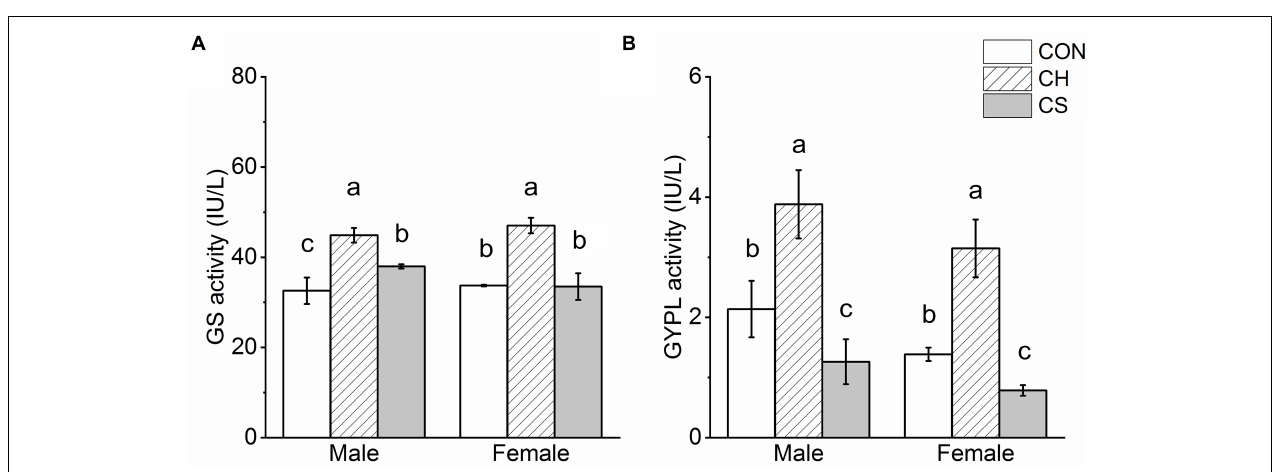
FIGURE 4 | Glycogen synthase (GS) and glycogen phosphorylase (GYPL) activity in cardiac muscle of voles. (A) GS activity. (B) GYPL activity. Values are mean ± SD. n = 8. CON, control group; CH, cool huddling group; CS, cool separated group. Different letters indicate significant differences among temperature treatment groups ( P <